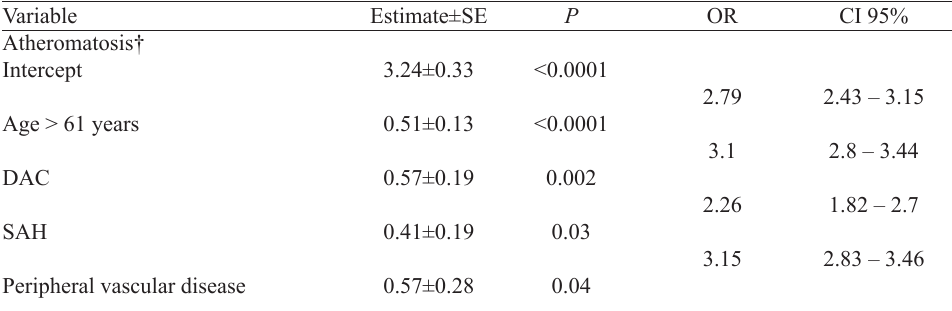
Table 2. Multivariate analysis of risk factors for atheromatous aorta in patients undergoing cardiovascular surgery.